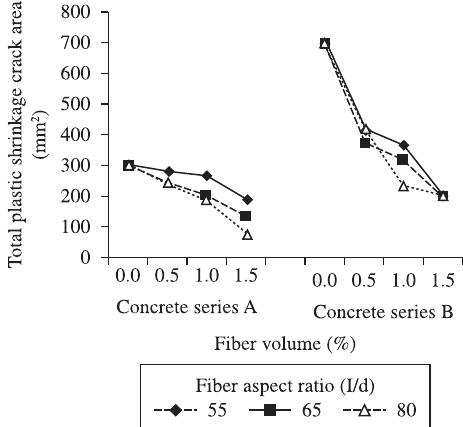
Figure 6. Effect of fiber volume on total plastic shrinkage crack area (mm 2 ), for series A and series B concretes.